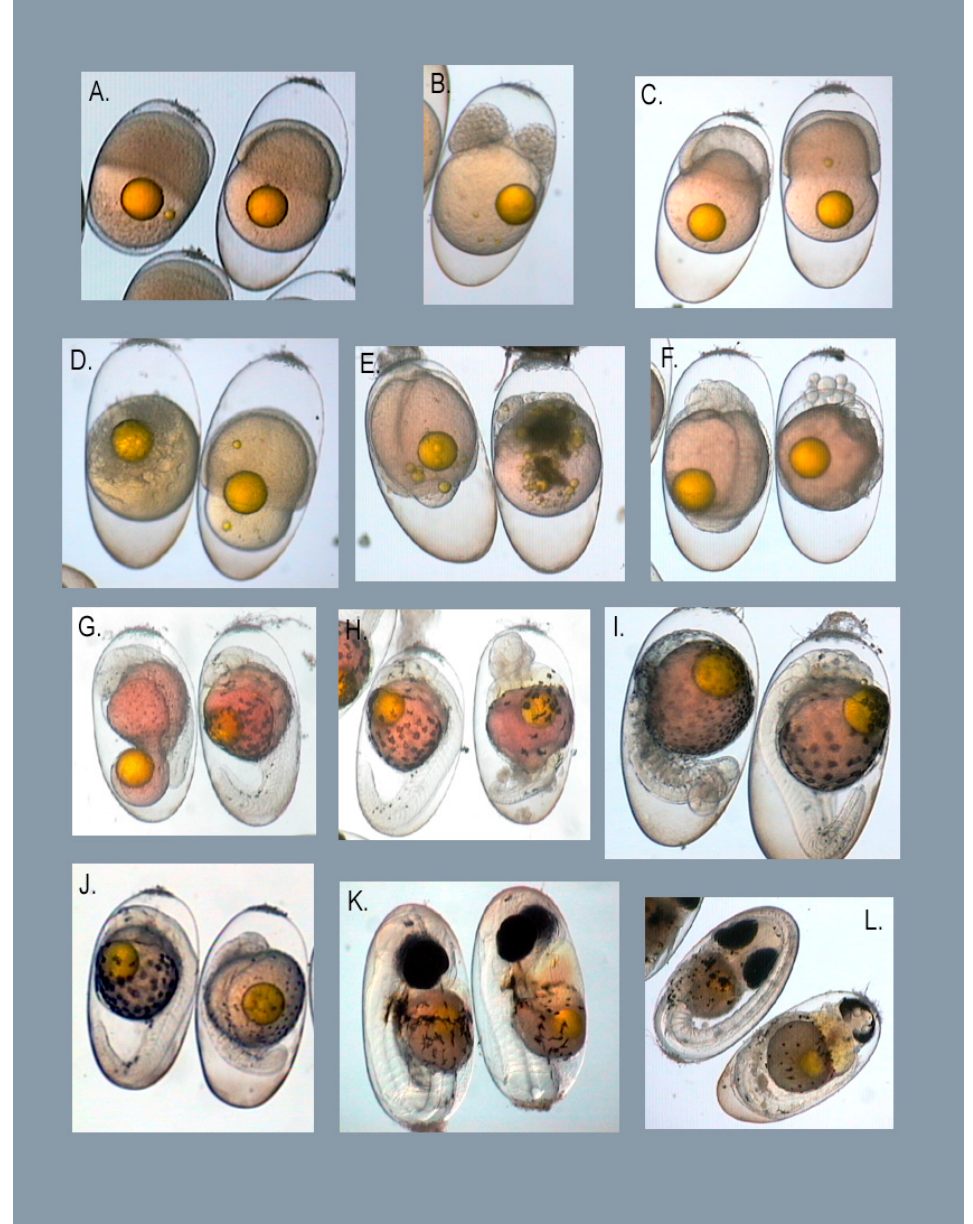
Figure 2. Common abnormalities observed in damselfish embryos. Abnormal embryos are paired with a normal embryo at the same developmental stage for comparison. Abnormalities observed fell into the following general categories; defects resulting from abnormal cleavage patterns in early embryos, defects resulting from abnormal cell movements during gastrulation, general developmental retardation, lack of morphological differentiation, cardiac, craniofacial, and axial/skeletal. ( A ). Unfertilized embryo. ( B ). Divided blastocap. ( C ). Enlarged segmentation cavity. ( D ). No differentiation. ( E ). Yolk abnormality, in addition to no differentiation. ( F ). Cells that have separated from the developing embryo and lack of differentiation. ( G ). Premature closure of the blastopore. ( H ). Skeletal and heart deformities. ( I ). Axial deformity. ( J ). Developmental retardation. ( K ). Heart deformity, tube heart with edema. ( L ). Partial eye fusion and heart deformity.